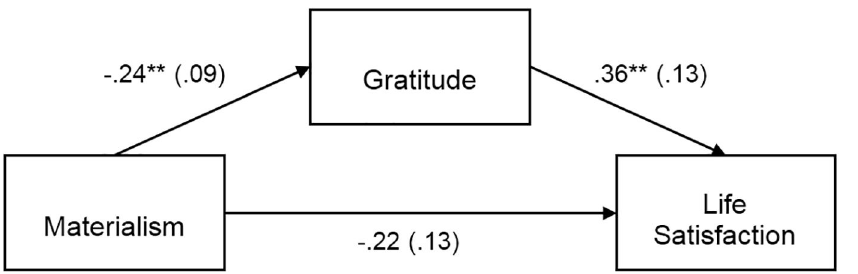
Figure 1. Materialism indirectly predicts life satisfaction through its relationship with gratitude, b = -.08, SE = .05, 95% CI [-.22, -.02]. Unstandardized coefficients shown with standard error in parentheses. ** p < .01.